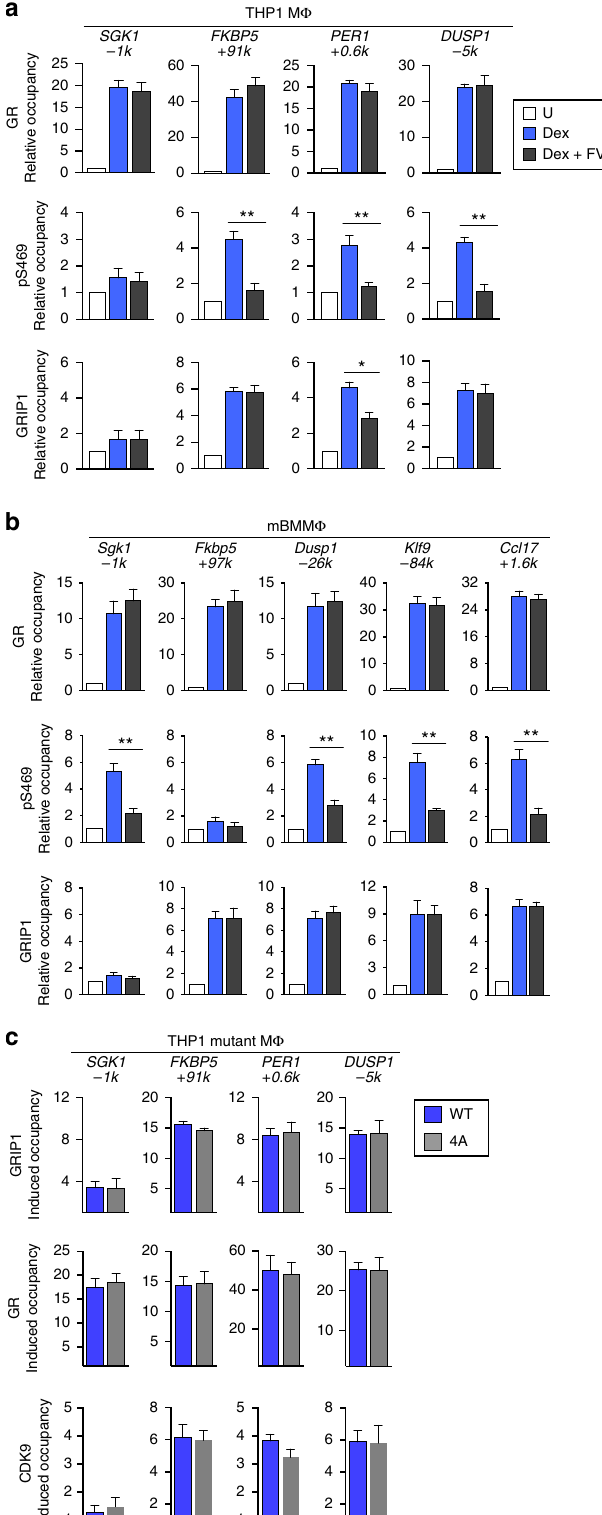
Fig. 5 GRIP1 phosphorylation affects its localization at a subset of genomic sites. THP1 cells ( a ) and BMM Φ ( b ) were treated ± dexamentasone (Dex) ± 50 nM fl avopiridol (FVP) for 1 h, and the occupancy of GR, pS469-GRIP1 and GRIP1 was analyzed by ChIP-qPCR as in Fig. 1f. c THP1-mutant-M Φ expressing WT or S469A/S487A/S493A/S499A (4A) mGRIP1 were treated ± Dex for 1 h and the expression of indicated genes was analyzed by RT-qPCR as in Fig. 1a and expressed relative to untreated cells for each genotype ( = 1). Means + SEM are shown ( n ≥ 3, * P < 0.05, ** P < 0.01;